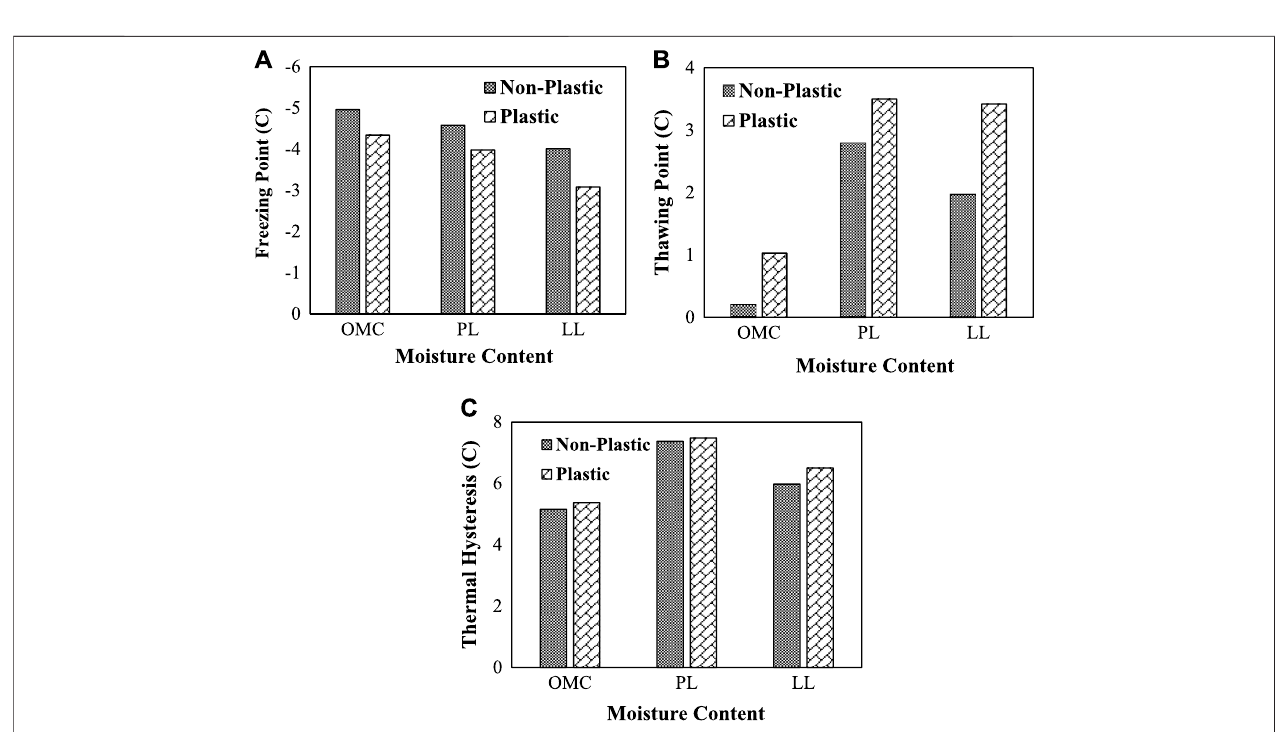
Frontiers in Built Environment |